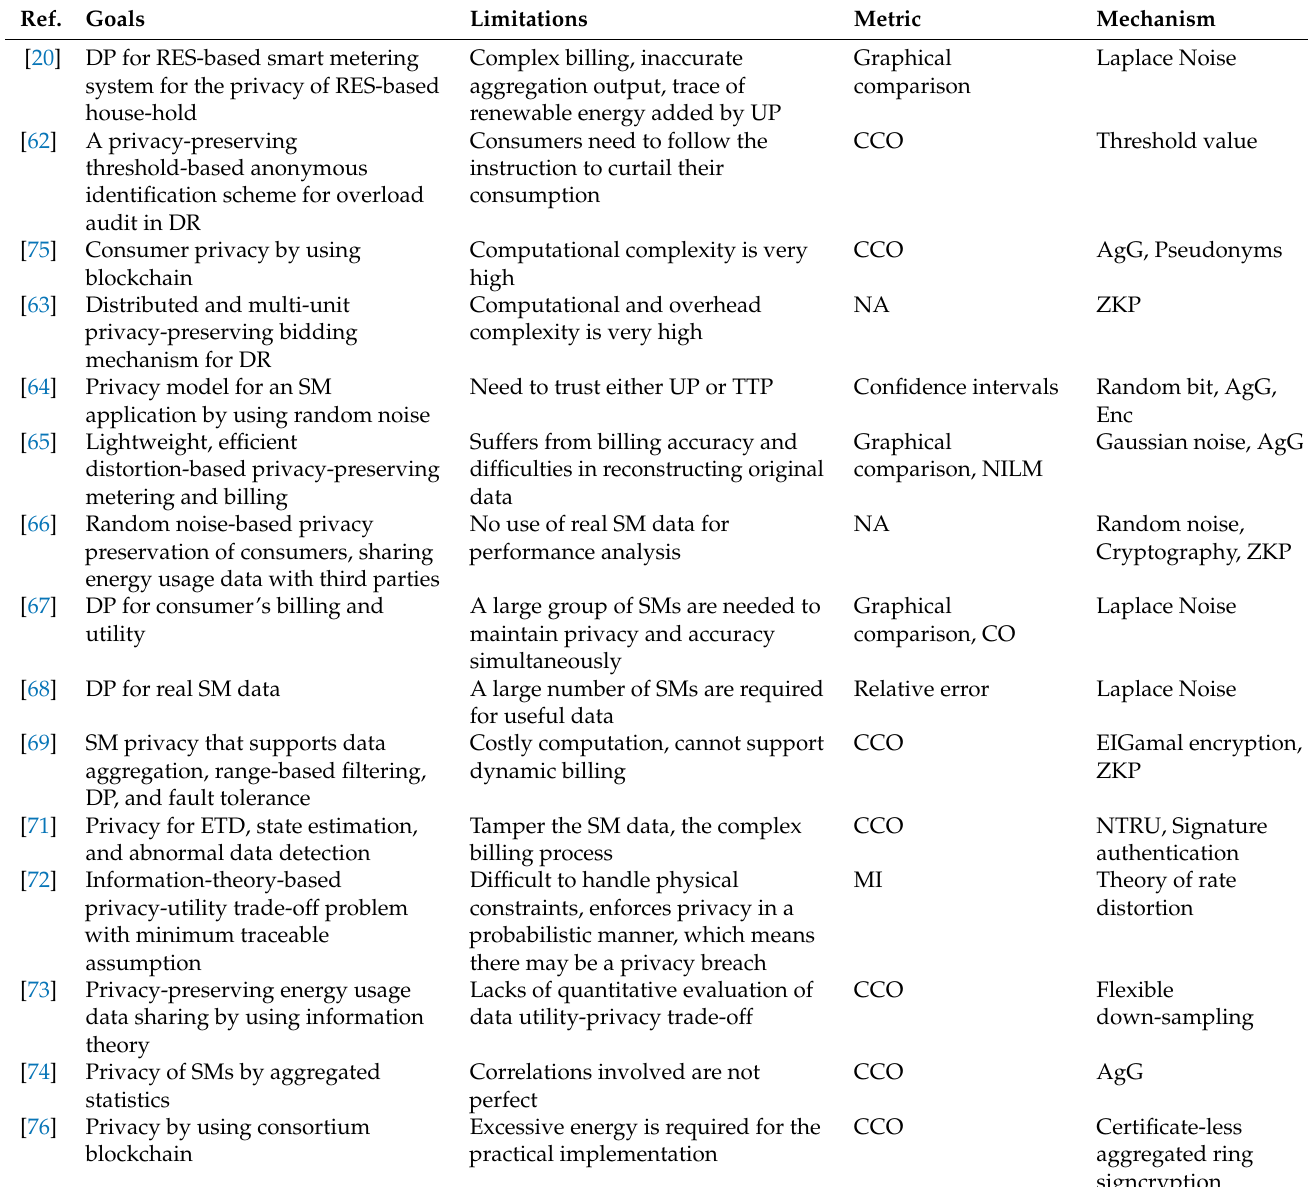
Table 3. Summary of SM privacy-preservation techniques for RES-based SM and data alteration against weak adversaries without